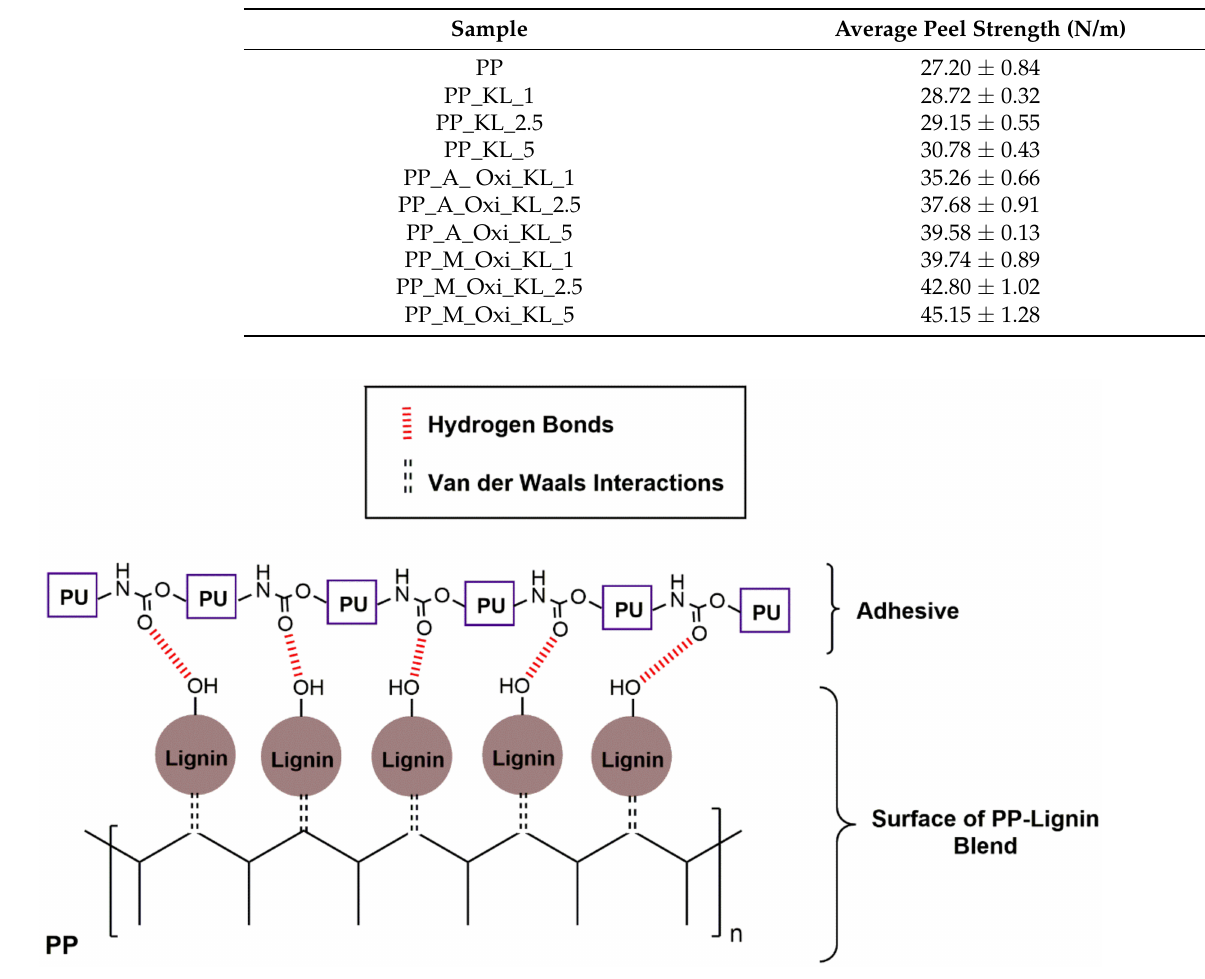
Figure 7. Proposed adhesion mechanism between PP-lignin composites and the